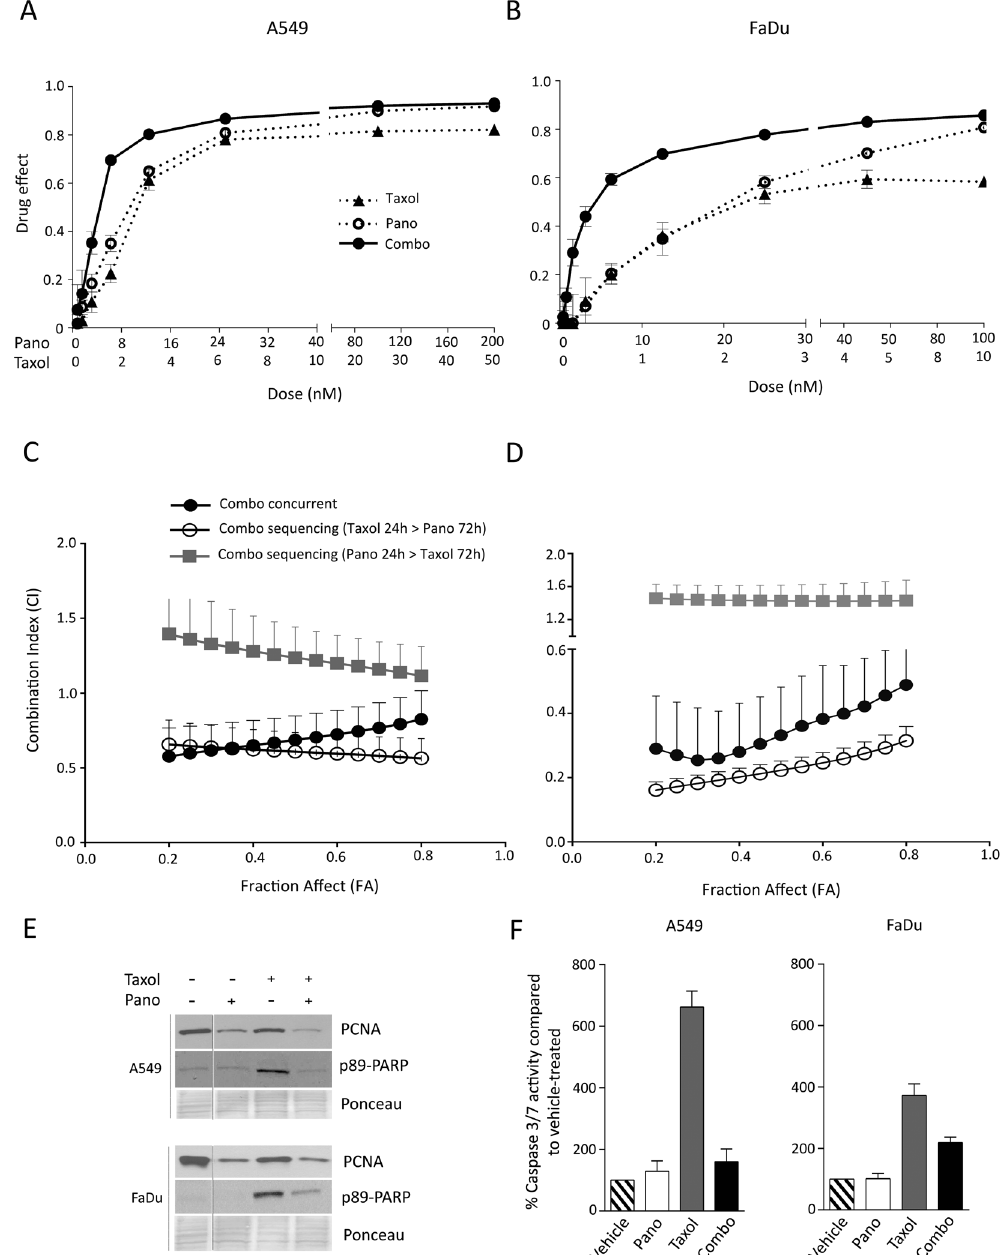
Figure 1. Synergy Between Taxol and Pano is Associated with Suppression of Proliferation in NSCLC and HNSCC. Dose response curves for Taxol, or pano and the concurrent combination in ( A ) A549 (NSCLC) and ( B ) FaDu (HNSCC) cells. Combination index (CI) versus Fraction Affect (FA) plots comparing concurrent and sequencing regimens, in ( C ) A549 and ( D ) FaDu. Each data point represents mean ± SEM ( n = 6). ( E ) Immunoblot analysis for proliferation (PCNA) and cell death (p89-PARP) to evaluate the effect of low dose, concurrent Taxol and pano treatment. Doses used were: Taxol - 6.25 nM (A549), 2.5 nM (FaDu) and pano- 25 nM (both cell lines) for 72 hrs. ( F ) Caspase 3/7 activity using the same conditions outlined in E . Activity is indicated as % relative to vehicle treatment. Each bar represents mean ± SEM ( n =